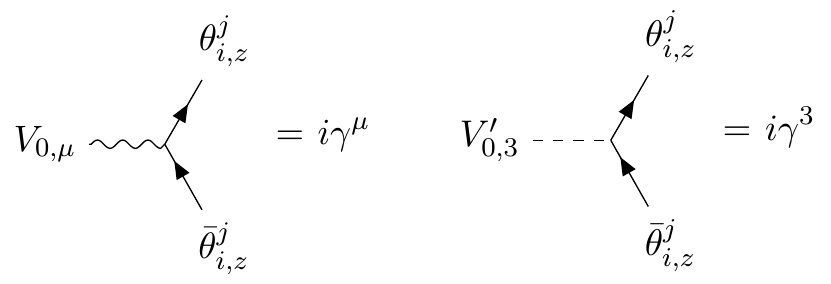
Figure 10. The vertices coupling the Dirac fermion to the U(1) V background.